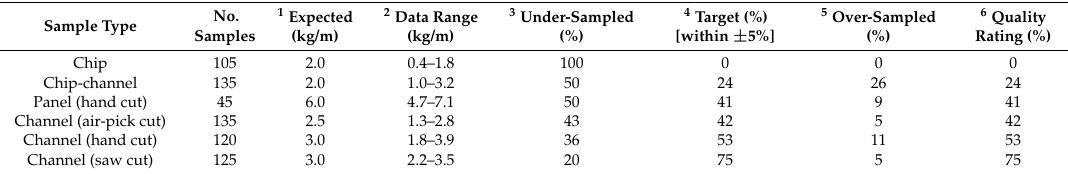
Table 15. Example of mass recovery (quality index (QI)) for linear samples across quartz-dominated vein mineralisation from a North American mine